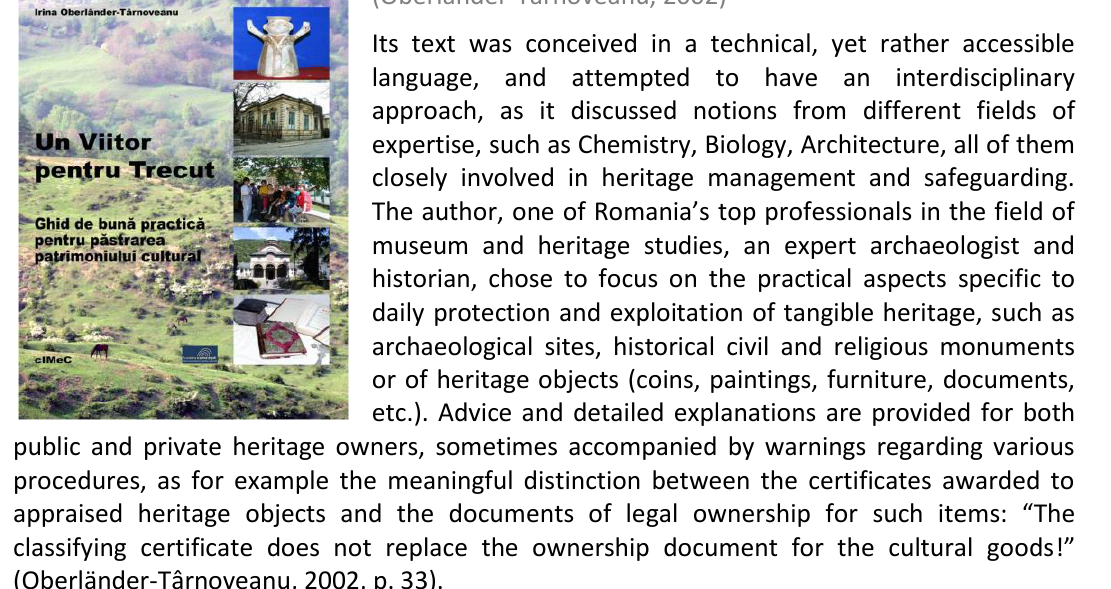
Figure 1: Front cover of the book A Future for the Past (Oberländer-Târnoveanu, 2002) Its text was conceived in a technical, yet rather accessible language, and attempted to have an interdisciplinary approach, as it discussed notions from different fields of expertise, such as Chemistry, Biology, Architecture, all of them closely involved in heritage management and safeguarding. The author, one of Romania’s top professionals in the field of museum and heritage studies, an expert archaeologist and historian, chose to focus on the practical aspects specific to daily protection and exploitation of tangible heritage, such as archaeological sites, historical civil and religious monuments or of heritage objects (coins, paintings, furniture,